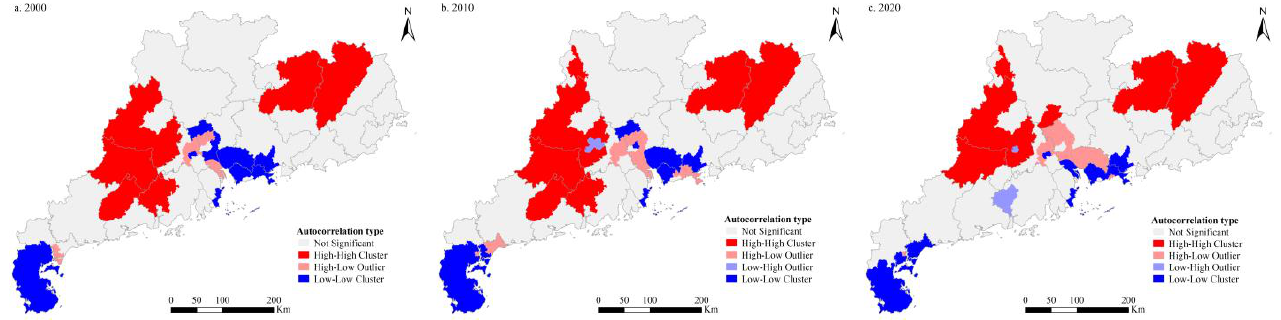
Figure 7. Local indicators of the spatial association (LESA) map of CLF in Guangdong Province on the county scale in 2000 ( a ), 2010 ( b ), and 2020 ( c ). LESA map of CLF in Guangdong Province on the county scale in 2000, 2010, and 2020 are displayed in ( a ), ( b ), and ( c ),